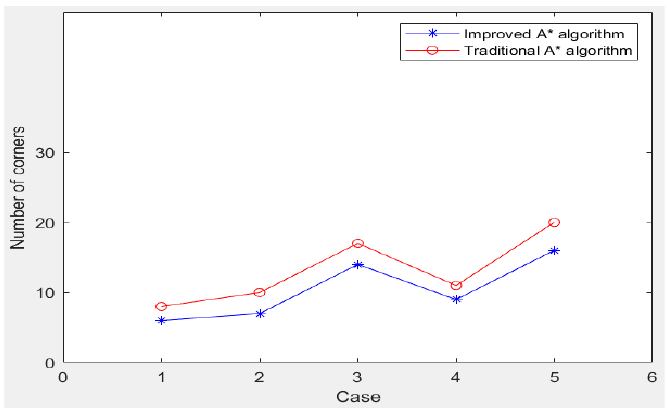
Figure 8. Comparison of the number of nodes.